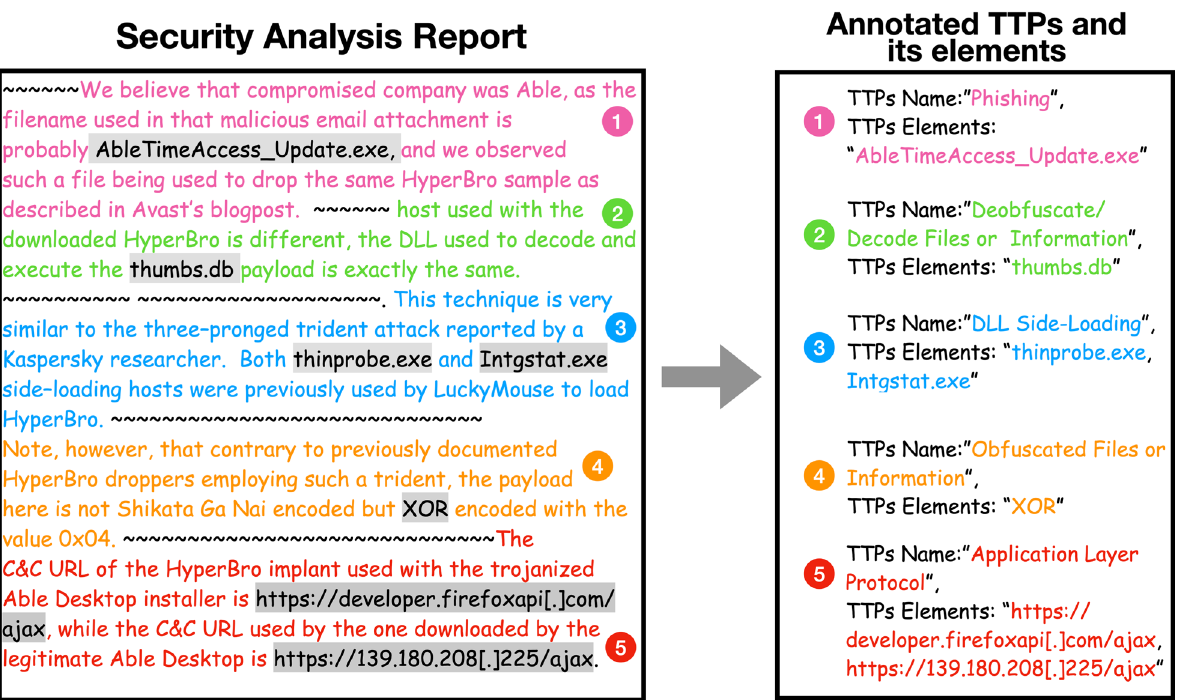
Fig. 1 The left figure is the origin security analysis report, and the right figure is the corresponding normalized TTP names and TTP elements. Security analysts need to manually extract these attack descriptions to normalize TTP names with the ATT&CK framework. Different colors in the figure represent different TTPs, and elements mentioned in the context are annotated with the gray